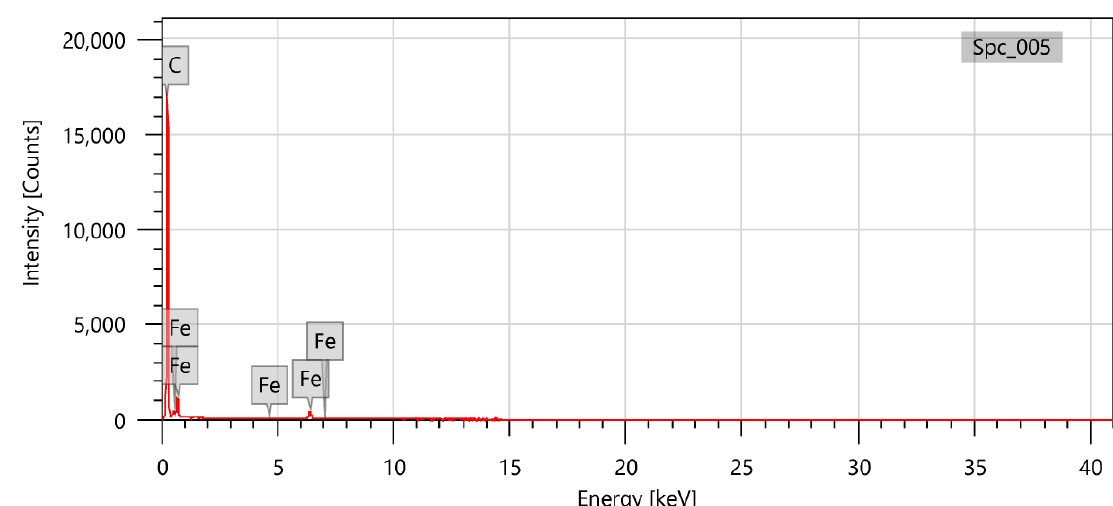
Figure 6. EDS analysis of the sample with an optimum flow velocity. Side view of the aligned nanotubes.